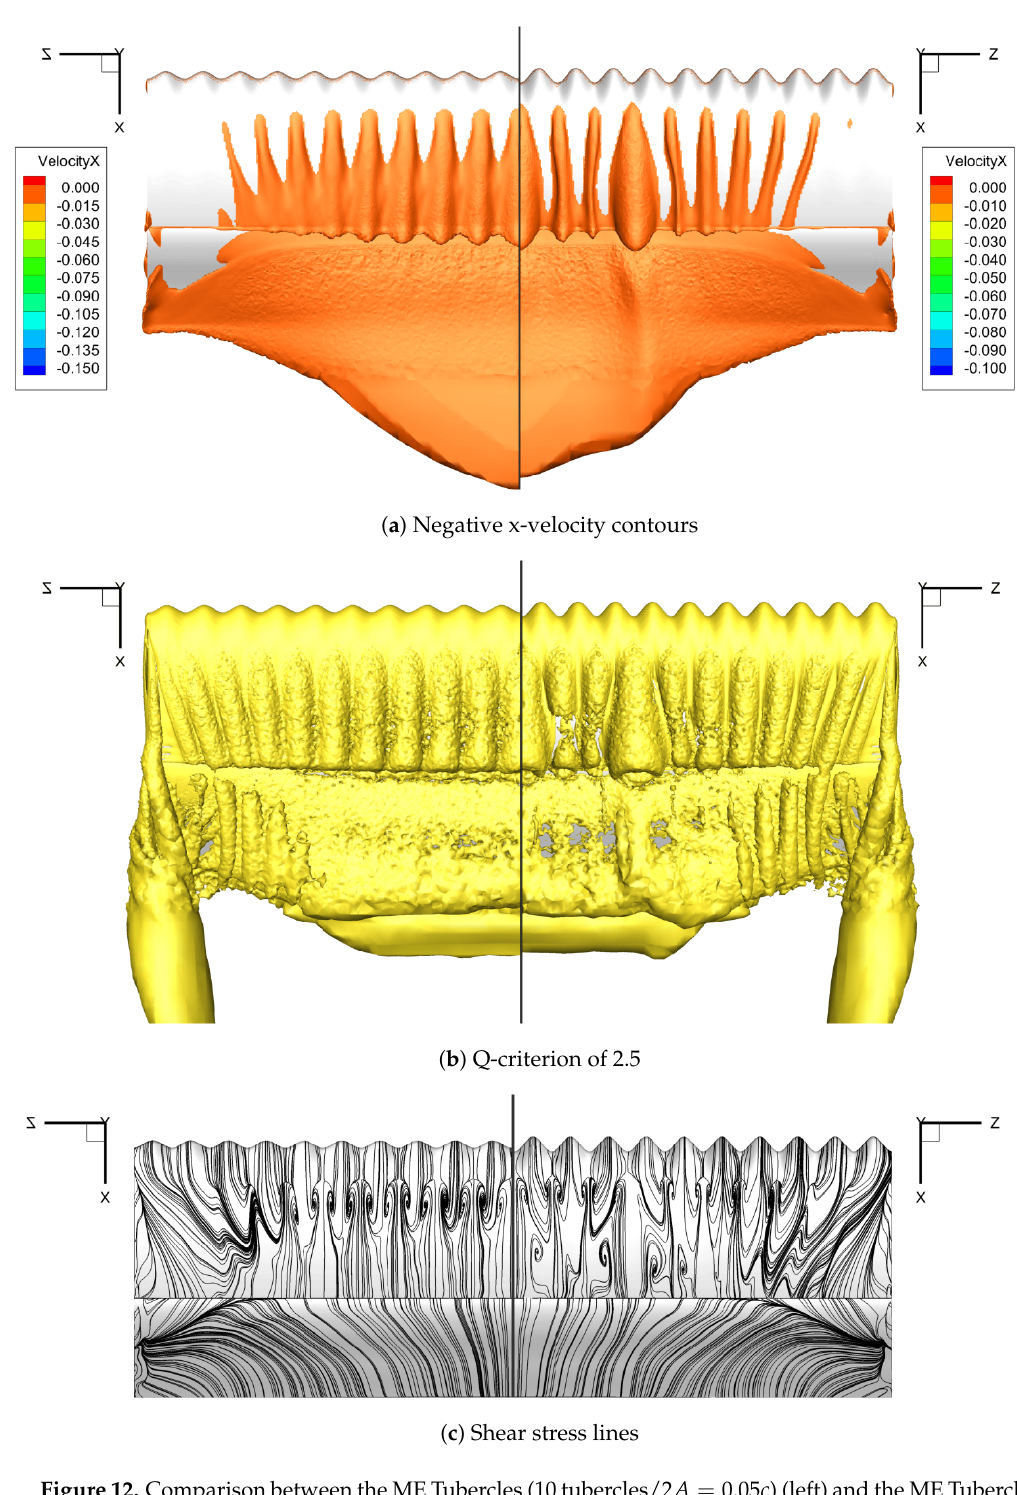
Figure 12. Comparison between the ME Tubercles (10 tubercles/2 A = 0.05 c ) (left) and the ME Tubercles (10 tubercles/2 A = 0.1 c ) (right) geometries. The geometries are seen from below and slightly from behind. The main element is at the top and the flap at the bottom. The flow is going from the top to the